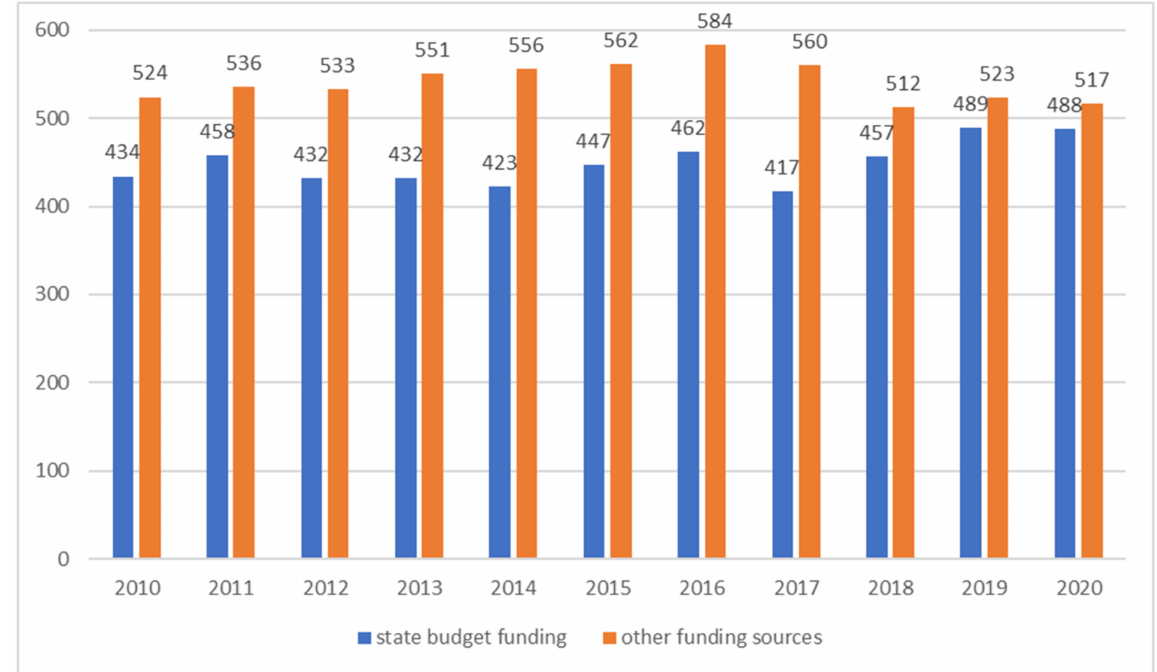
Figure 2. Number of PRVT tests conducted, 2010–2020.